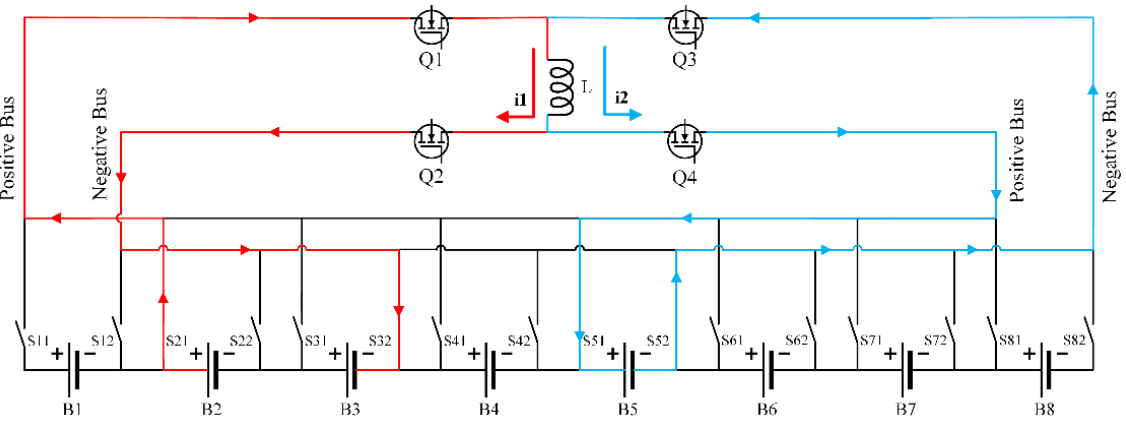
Figure 3. Multi-cell-to-any-cell balancing.